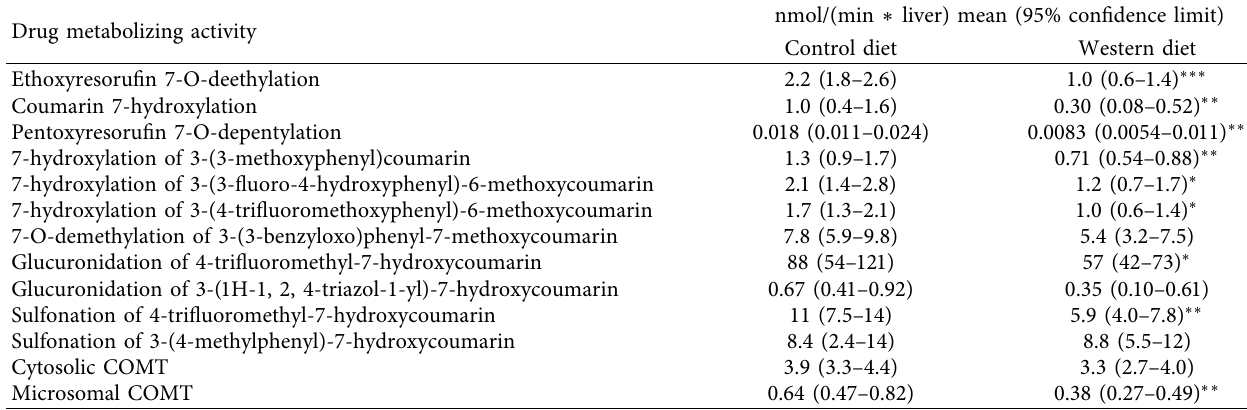
Table 1: Te efect of a Western diet (WD) on the total probe drug metabolism of the mouse model of NAFLD. Te liver microsome and cytosol fractions were prepared from the livers of eight months old male LDLr − / − ApoB 100/100 mice that were fed either with chow (8 mice) or WD (10 mice) for fve